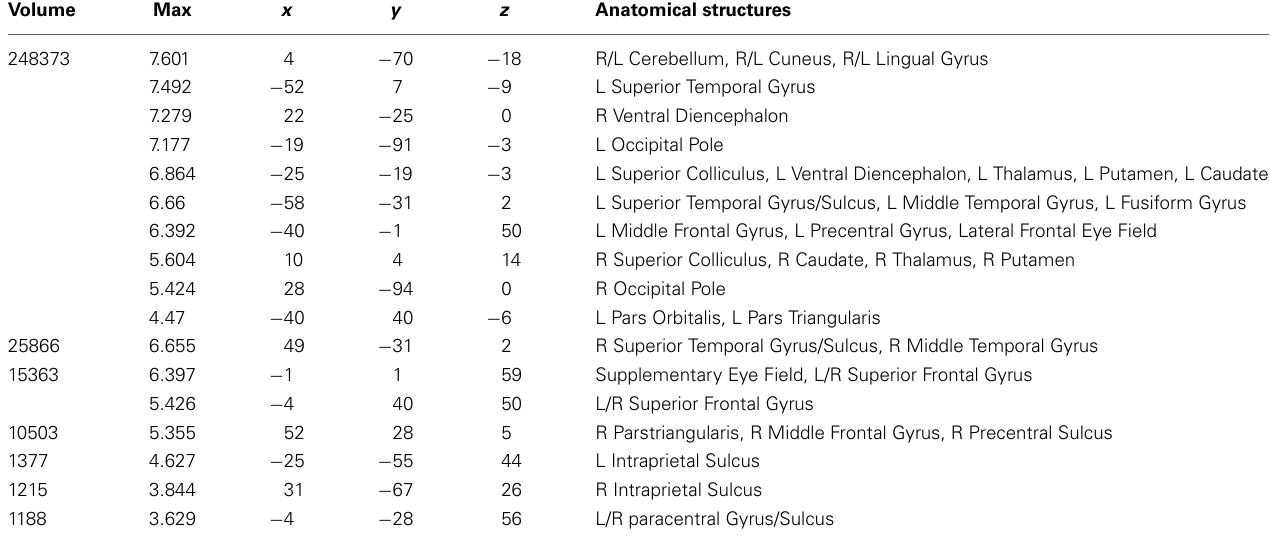
Table 2 | Talairach coordinates, volume of the cluster ( µ l), maximum z-score, and the label of anatomical structure for the normal text (NT) condition > fixation analysis, L, left hemisphere; R, right hemisphere.